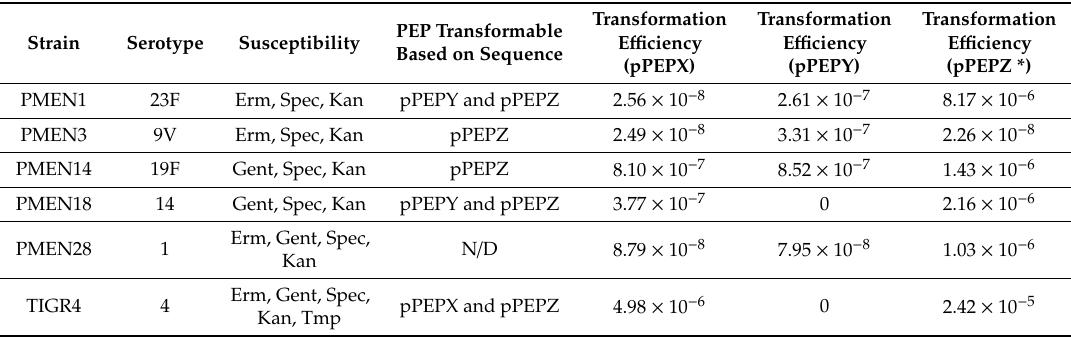
Table 2. Transformation e ffi ciency of PEP vectors into various pneumococcal strains. Spec— spectinomycin, Kan—Kanamycin, Gent—Gentamycin, Erm—Erythromycin, Tmp—Trimethoprim. *—pPEPZ plasmid chosen based on susceptibility of strain.